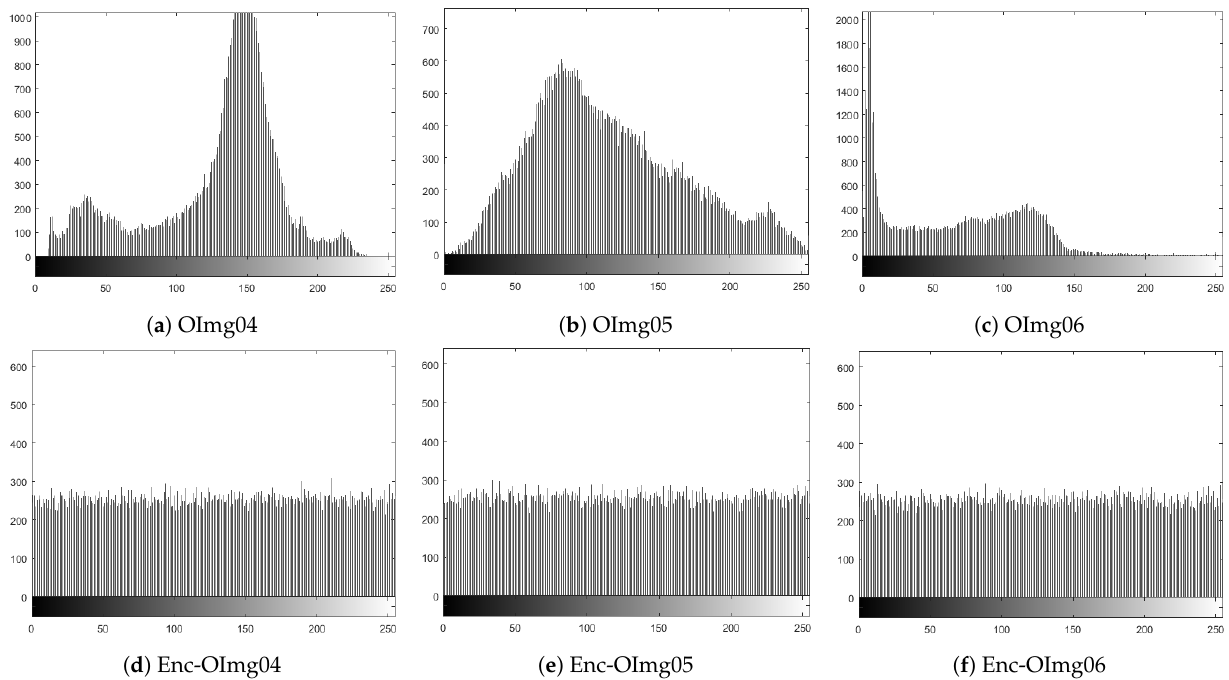
Figure 8. Histograms ( a – f ) for grayscale images and their encrypted version before embedding onto the